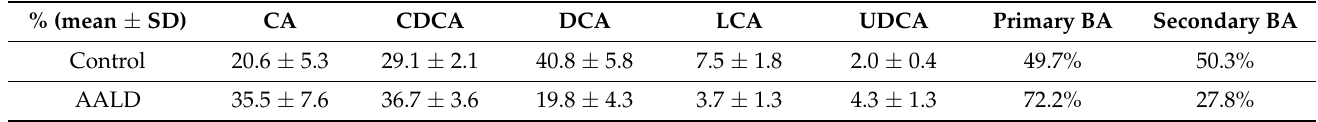
Table 2. Percentage of total bile acid pool in human serum.